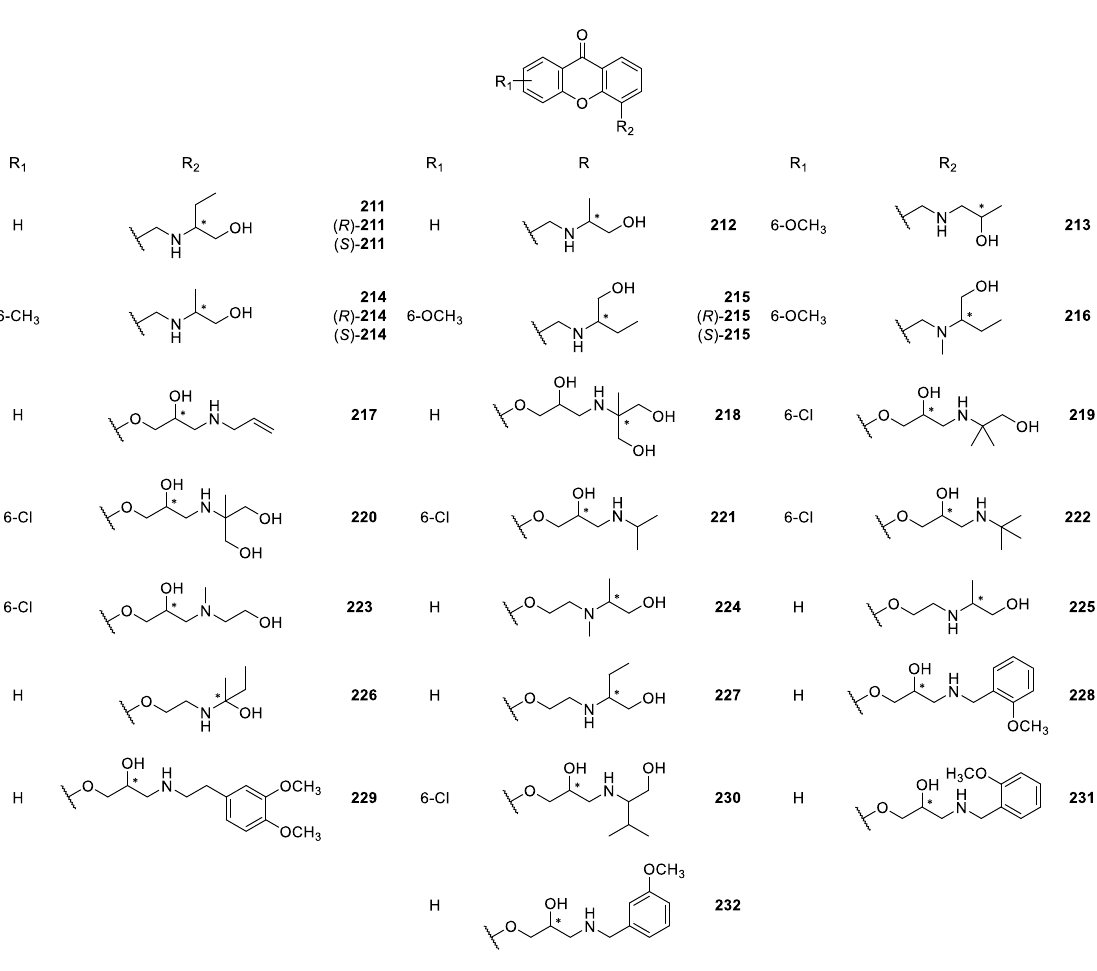
Molecules 2019 , 24 , x FOR PEER REVIEW Figure 19. Structures of 4-aminoalkanolic CDXs 211 – 232 . Figure 19. Structures of 4-aminoalkanolic CDXs 211 – 232 .